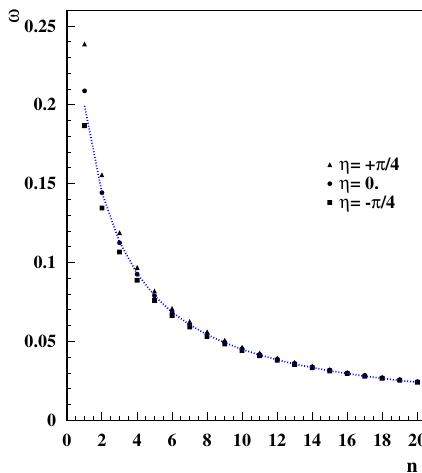
Fig. 2 Eigenvalues ω n determined in NLO for three fixed non- perturbative phases, η n . The dotted line shows a simple parametrisation described in the